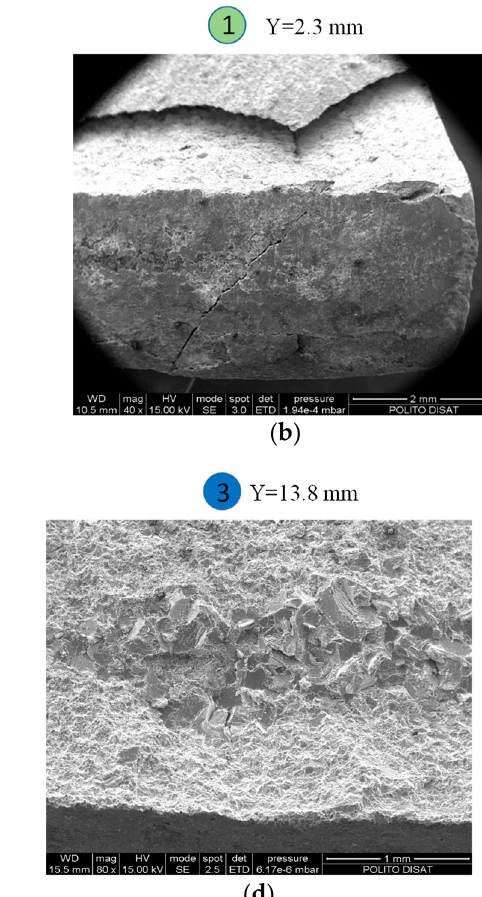
Figure 8. Friction coefficient measure with test rig flat on flat surface [23,24].